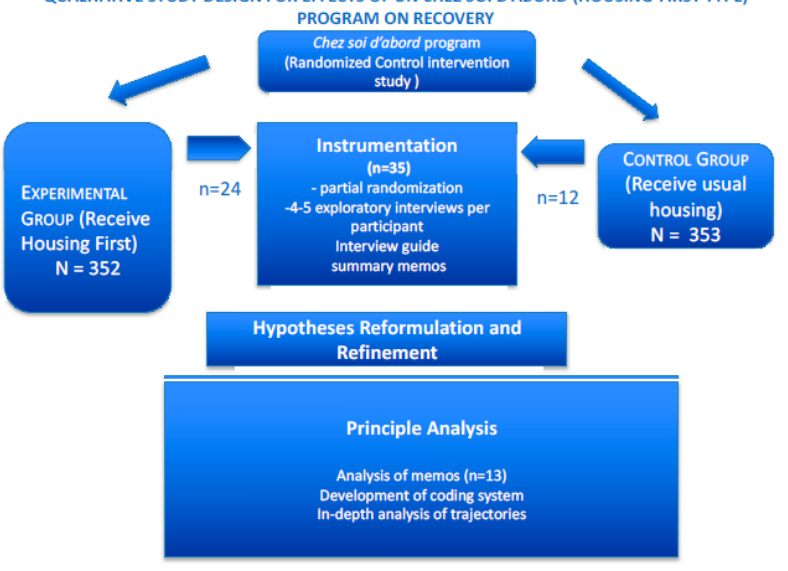
Figure 1. Research Design of Qualitative